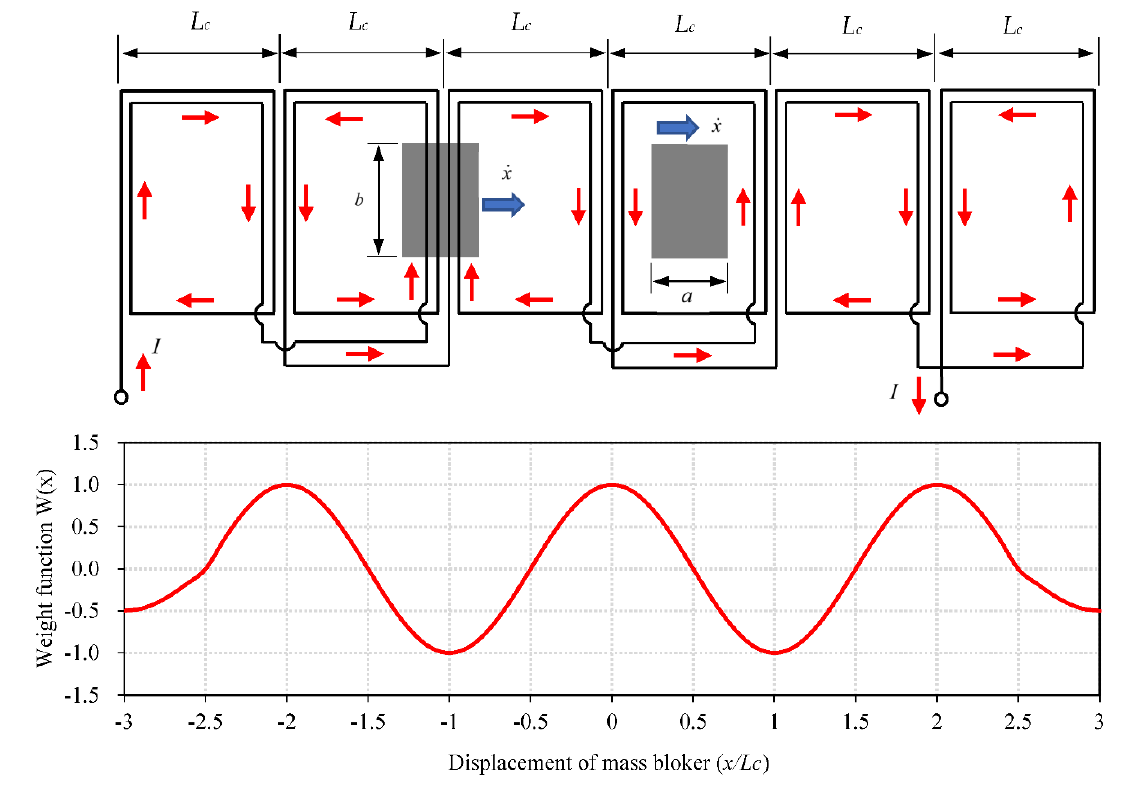
Figure 5. Magnet and coil positioning and placement weight function W ( x ) for vibratory power generation.